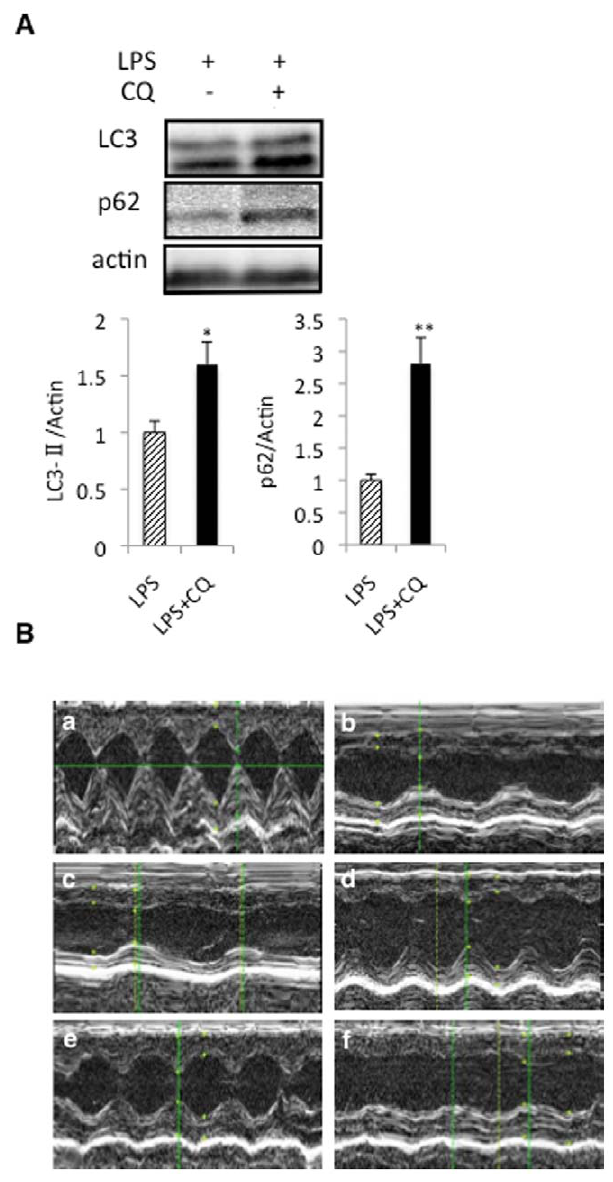
Figure 8. Effects of CoPPIX on left ventricular function during LPS treatment in rats. A, Western blot analysis of the rat heart with or without CQ treatment (20 mg/kg) with LPS treatment (15 mg/kg, 3 h) to determine the levels of LC3-II and p62. The ratios of LC3-II and p62 to actin were determined by densitometry analysis and are also represented. Each bar represents the mean 6 S.E. of four animals. **p , 0.01; *p , 0.05 vs. none. B, Representative echocardiographs in each group are shown: control (a), LPS for 3 h (b), LPS + CoPPIX for 3 h (c), LPS for 24 h (d), LPS + CoPPIX for 24 h (e), and LPS + CQ for 24 h (f). doi:10.1371/journal.pone.0056526.g008 heart against LPS-elicited oxidative stresses. These histological observations (Fig. 7 A and B) were found in all the samples (four rats/group) (data not shown). To further confirm the heart damage, we examined the plasma concentrations of serological markers of myocardial damage. We first examined plasma levels of aspartate aminotransferase (AST), which is mostly found in the liver and heart. AST was detected in the plasma after 6 hours and was found to be increased for at least 48 hours during LPS